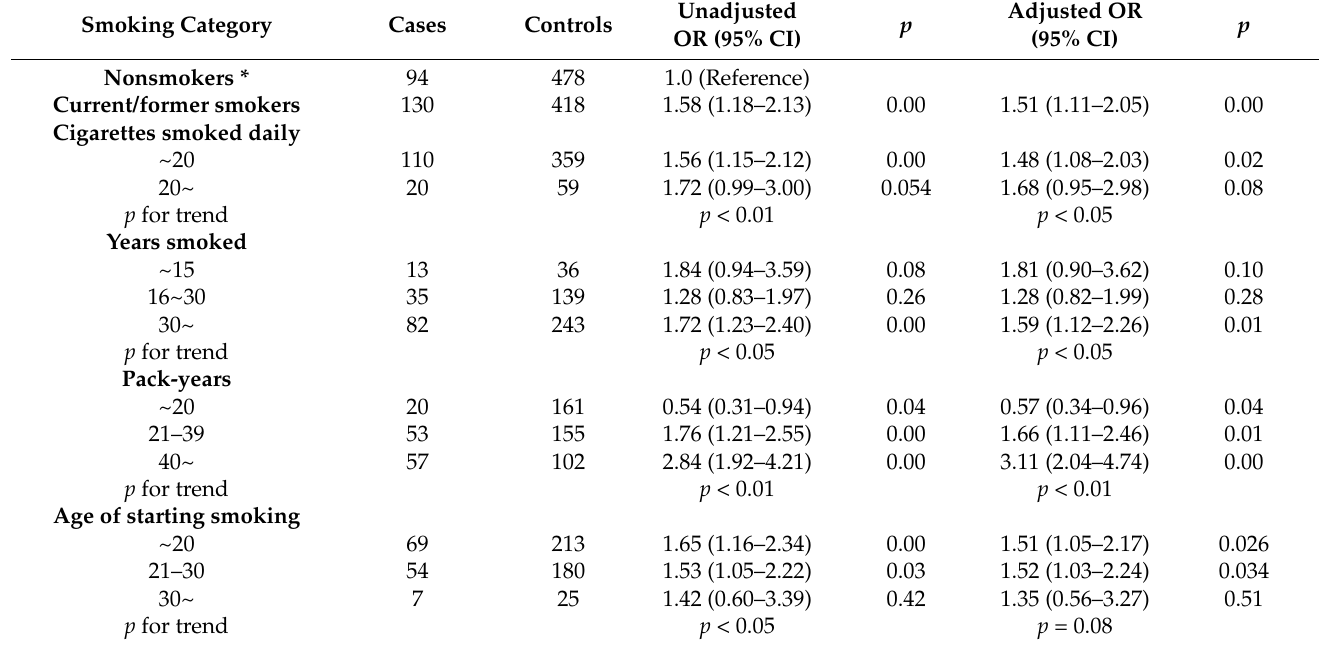
Table 3. Adjusted OR and 95% CIs for the associations between smoking and the prevalence of COPD within the Jinchang Cohort